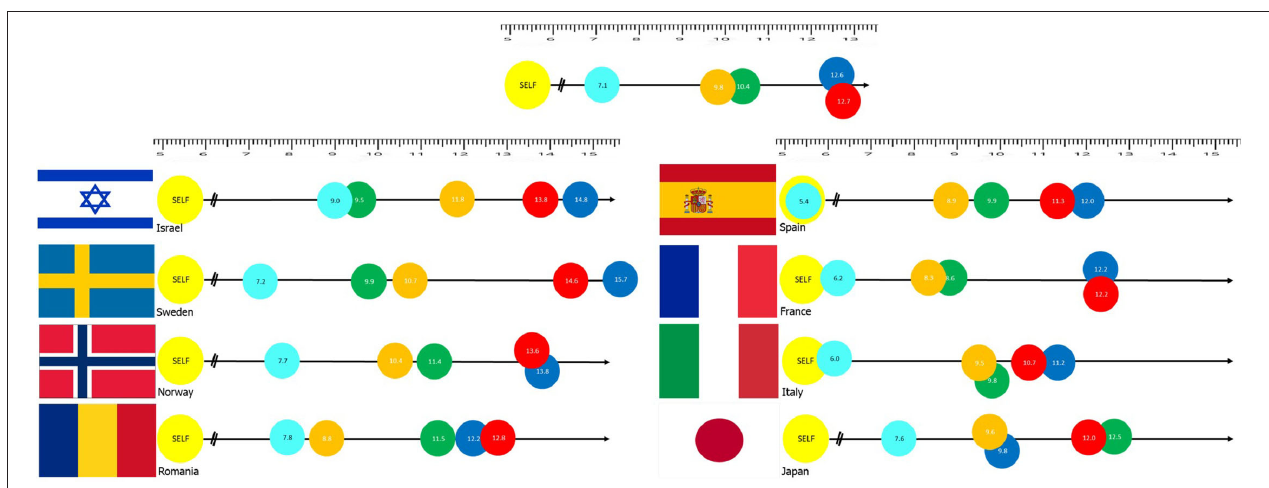
FIGURE 1 | Results of the iPRISM tool assessing risk awareness through distances assigned by participants between themselves (yellow “SELF” disk) and specific risk objects [Light blue: Pandemics, Orange: Critical infrastructure fail (water, energy), Green: Social disruption (e.g., war), Blue: Natural Hazard (e.g., earthquakes), and Red: Extreme weather]. Top image is overall sample ( N = 4,013). National samples are presented with their flag on the right of the image.